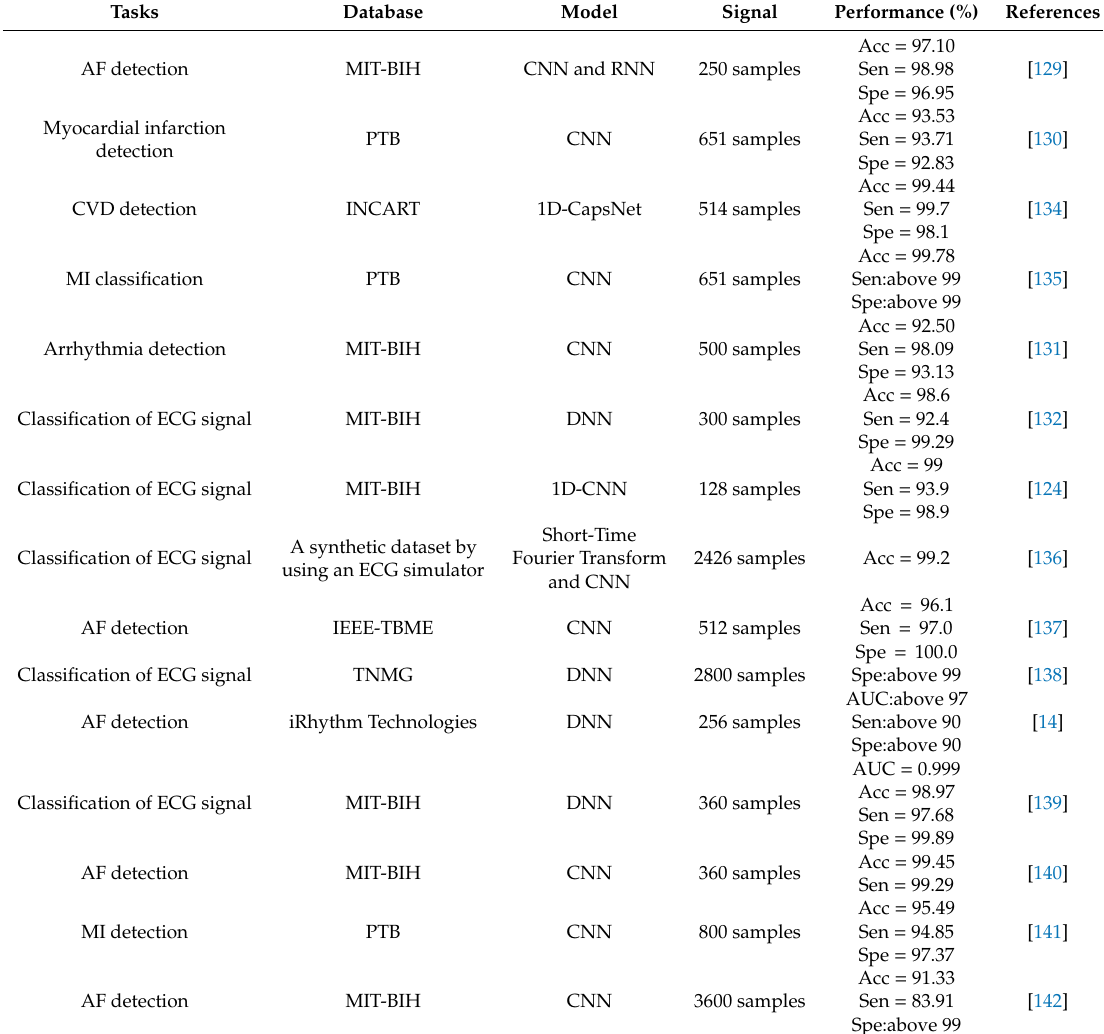
Table 2. ECG analysis with end-to-end